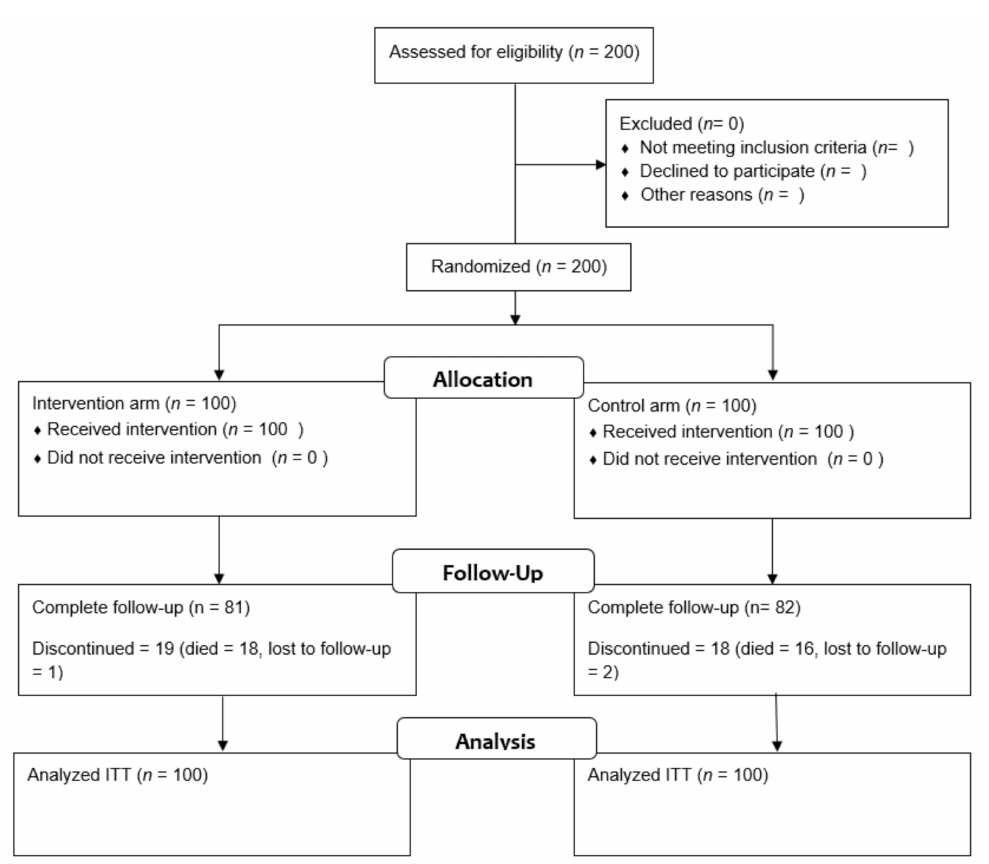
Figure 1. Consort flow diagram of progress through the randomized study. ITT: intention to treat. The median age was 58.83 years (range, 36.56–87.89) in the intervention arm and 56.70 years (range, 39.80–86.56) in the control arm. Sociodemographic and clinical